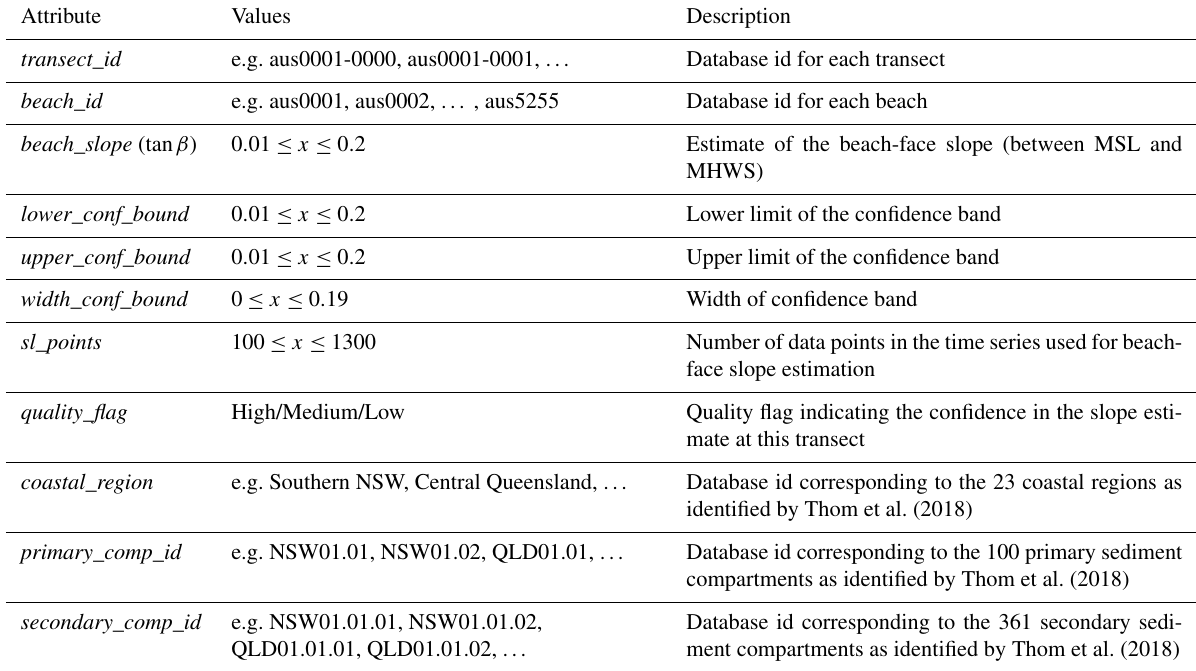
Table 1. Description of data fields for the beach-face slope dataset at the transect scale.